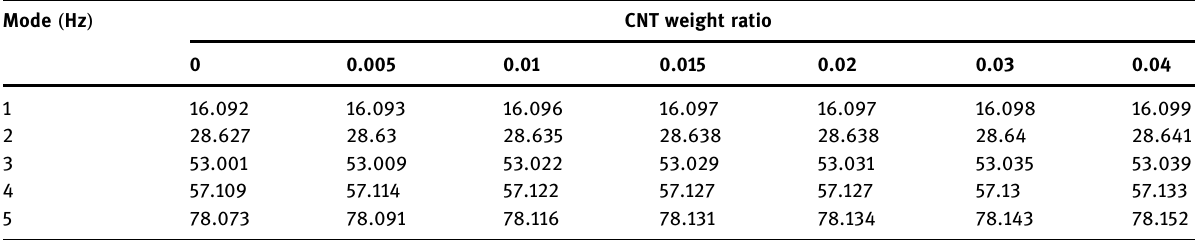
Table 12: Natural frequencies of the beam with di ff erent CNT weight ratio